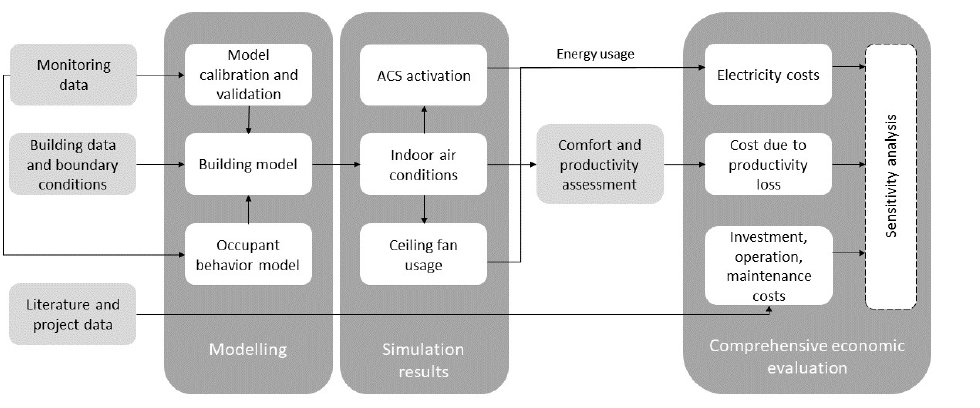
Figure 1. Methodology